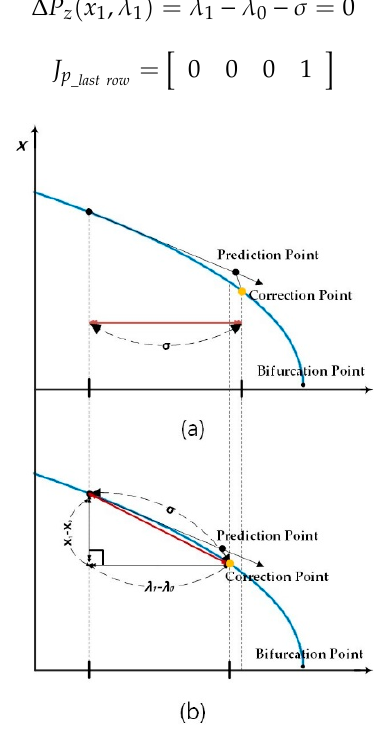
Figure 2. Parameterization comparison between ( a ) local and ( b ) arc length.